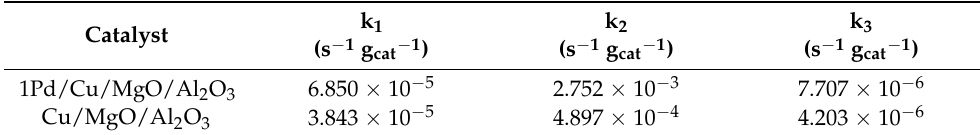
Table 3. Pseudo-first-order kinetics parameters comparison between Cu/MgO/Al 2 O 3 and